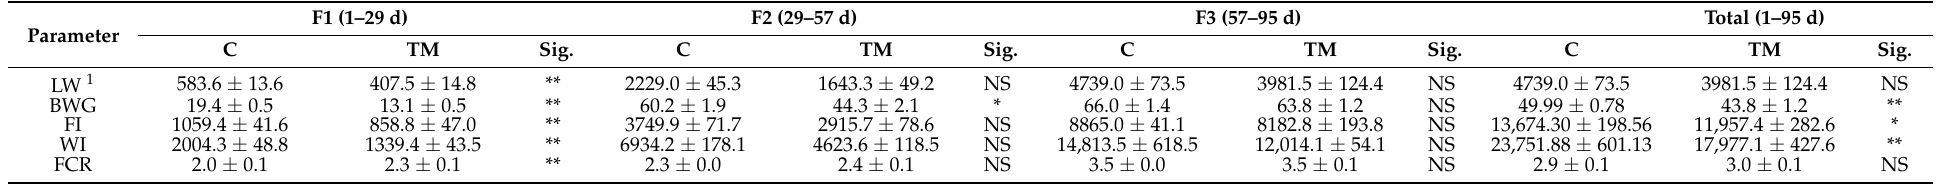
Table 3. Total production performance parameters of the two studied chicken groups (C and TM) for the three different diets (mean ± SEM).